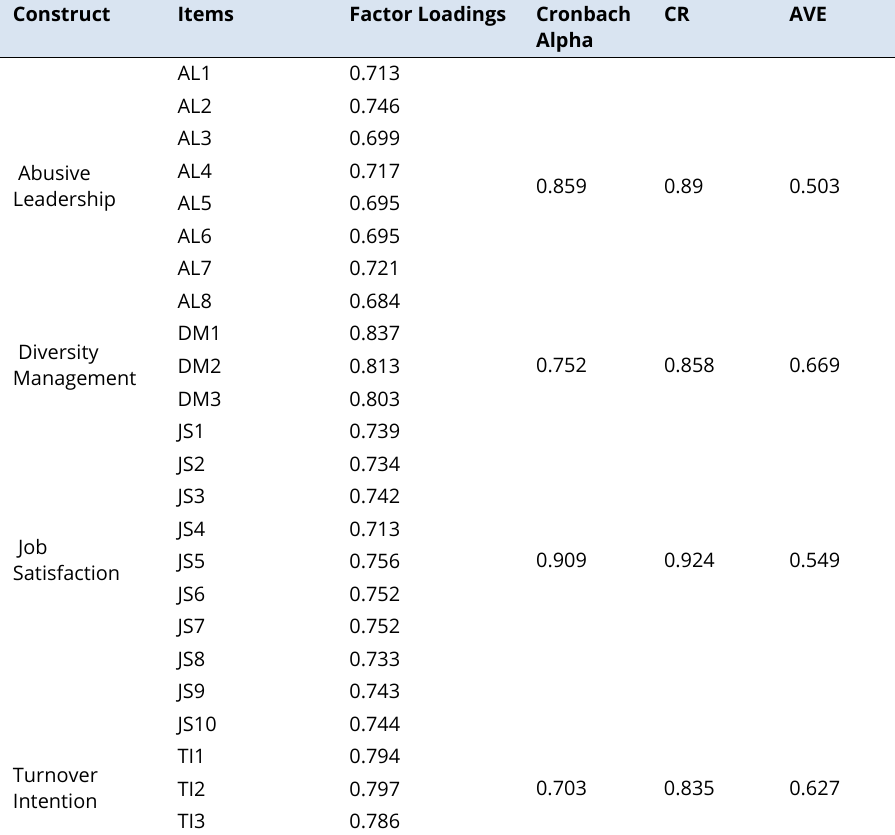
Constructs reliability and validity test measurement